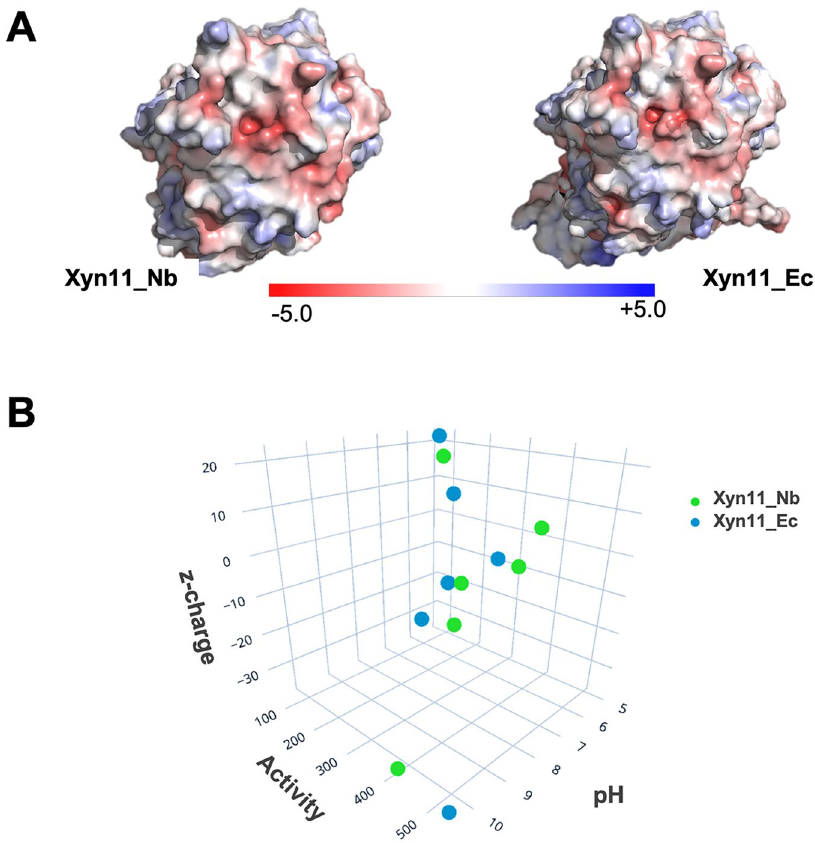
Figure 5. Comparative structure and pH dependent activity of the xylanase Xyn11 produced in N. benthamiana (Xyn11_Nb) and E. coli (Xyn11_Ec). ( A ) Charged surface potential representation of models of the two proteins based on the crystallographic structure of Xyn11 (PDB id: 7NL2), calculated using APBS electrostatic software (https:// www. poiss onbol tzmann. org) and rendered with Pymol 2.3.4 (https:// pymol. org/). ( B ) 3D scatter plot representation of xylanase activity and protein net charge (Z) as a function of pH